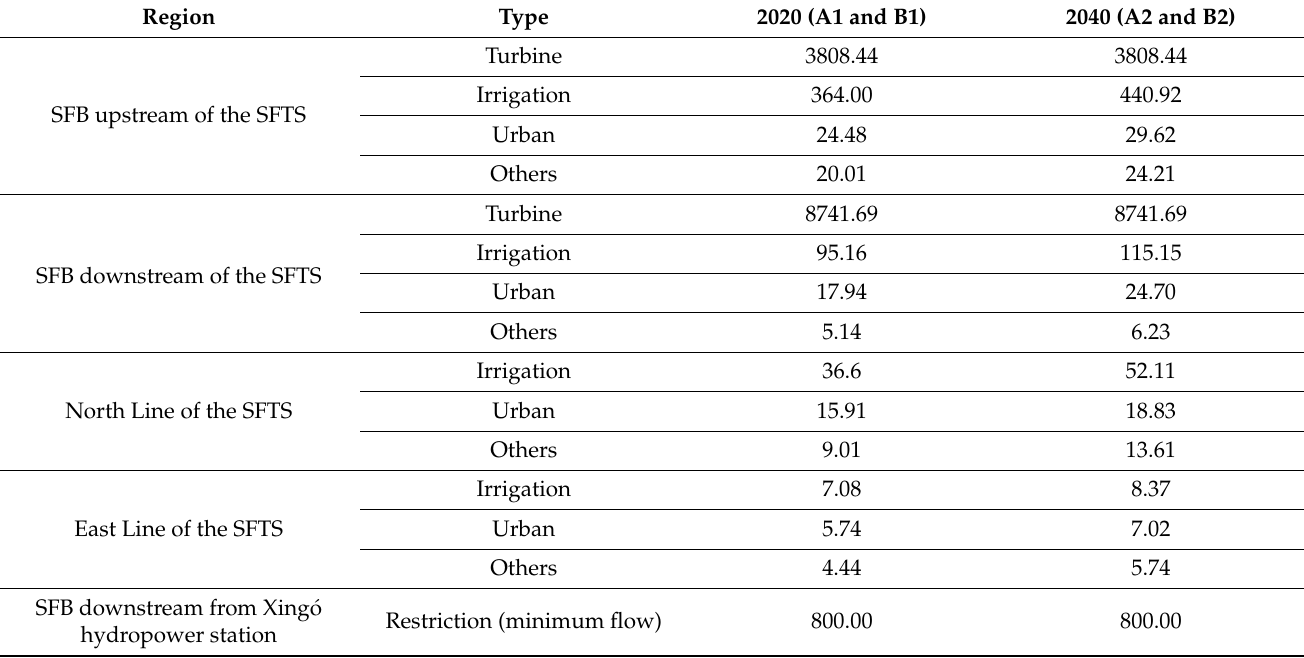
Table 1. Summary of the water demand scenarios, in m 3 · s − 1 (adapted from [43]). Region